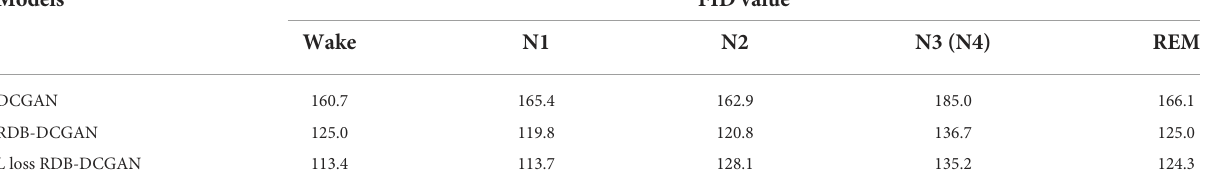
TABLE 2 Comparison of FID values of data generated by different